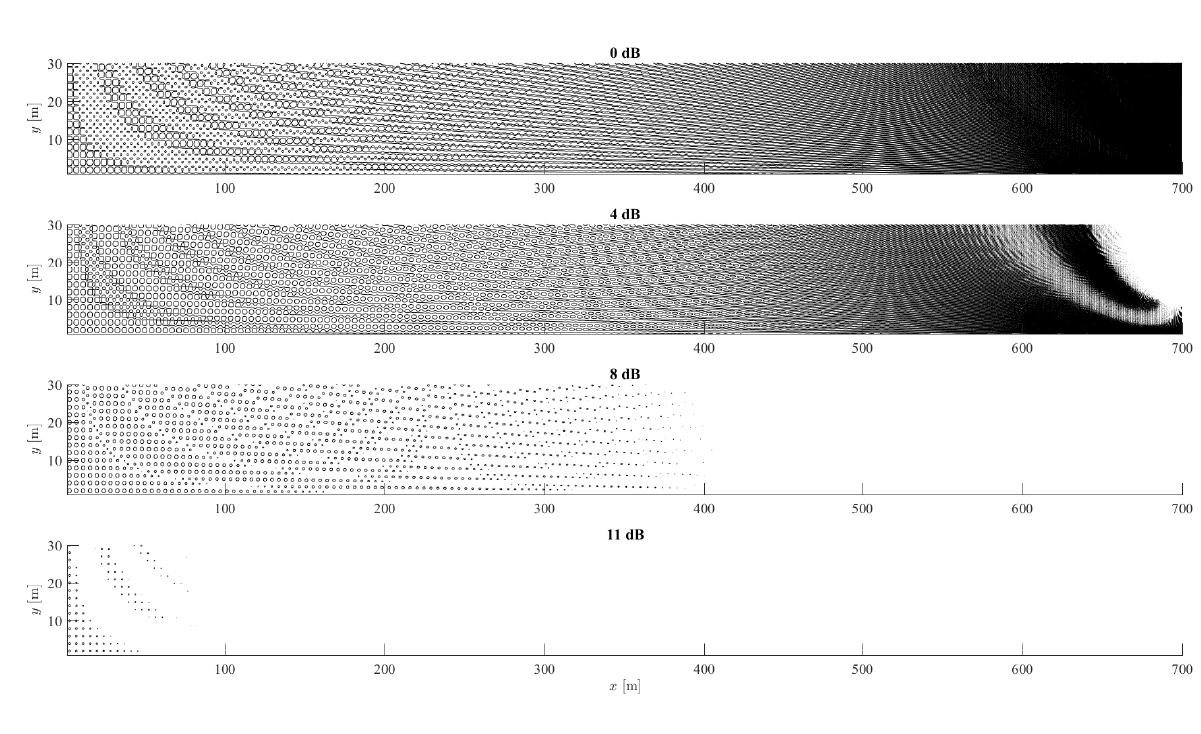
Figure 10: Map of the modulus of the multipath factor F as a function of observer position in the plane for a fixed source position at the upper right corner in each plot, for rigid walls, R h = R v = 1 and for the frequency f = 2003.9Hz . The variables x and y in the axis labels stand for the distances to the vertical and horizontal walls